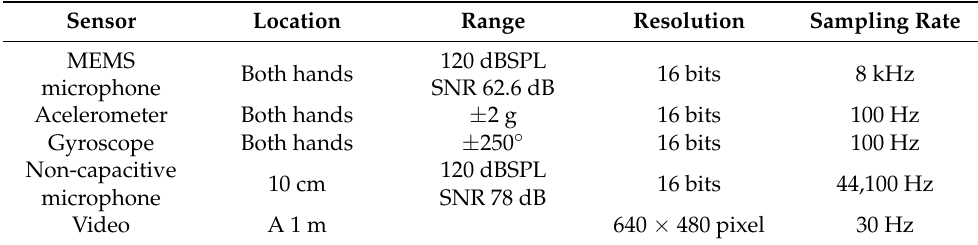
Figure 2. Measurement: ( a ) equipment used, ( b ) recording of the embedding process with an external microphone, ( c ) glove with the acquisition system. Table 1. Features of the sensing components.